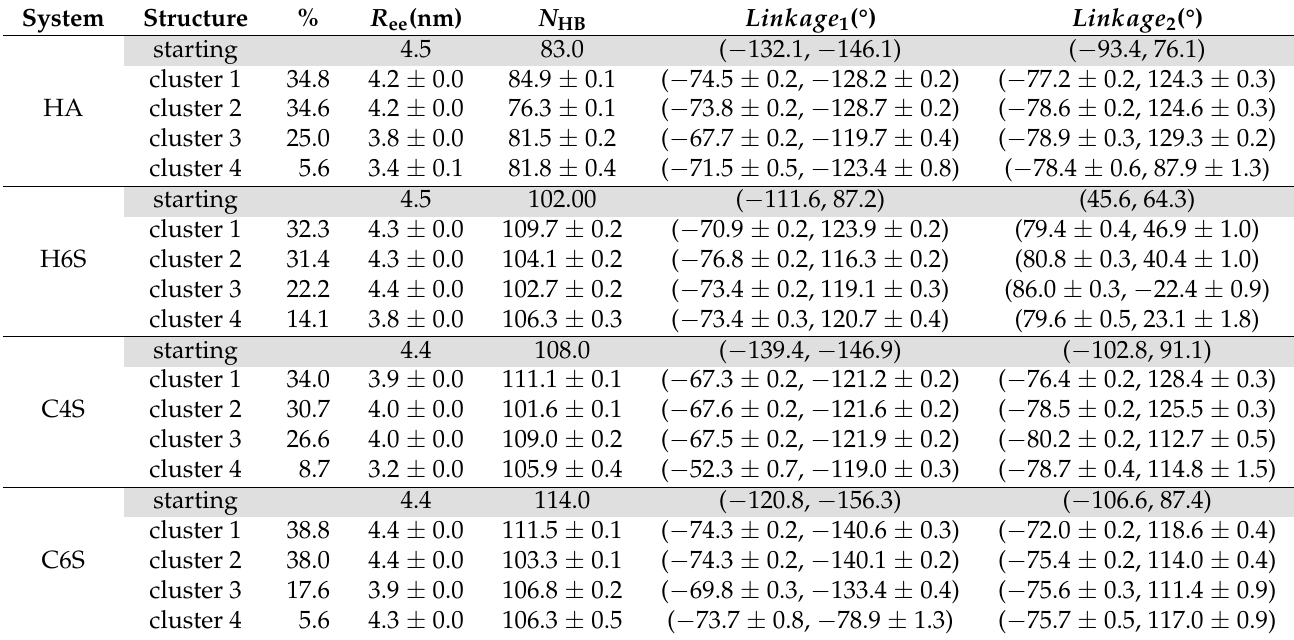
Table 3. The values of R ee , N HB , phi , and ψ pairs for Linkage 1 and Linkage 2 of the centroid structures of the four clusters (populations are provided below) obtained for the GAGs at 150 mM NaCl. The corresponding values of the initial structures used in the MD simulations are provided as well (mean ± standard